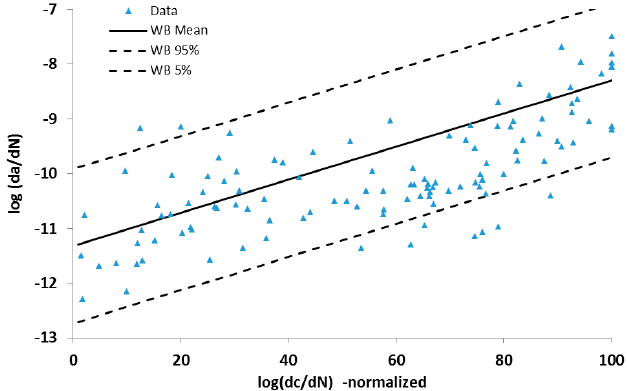
Figure 7. Posterior predictive AE model with the uncertainty bounds, material: Al7075-T6; WB indicates Bayesian regression analysis results using WinBugs.